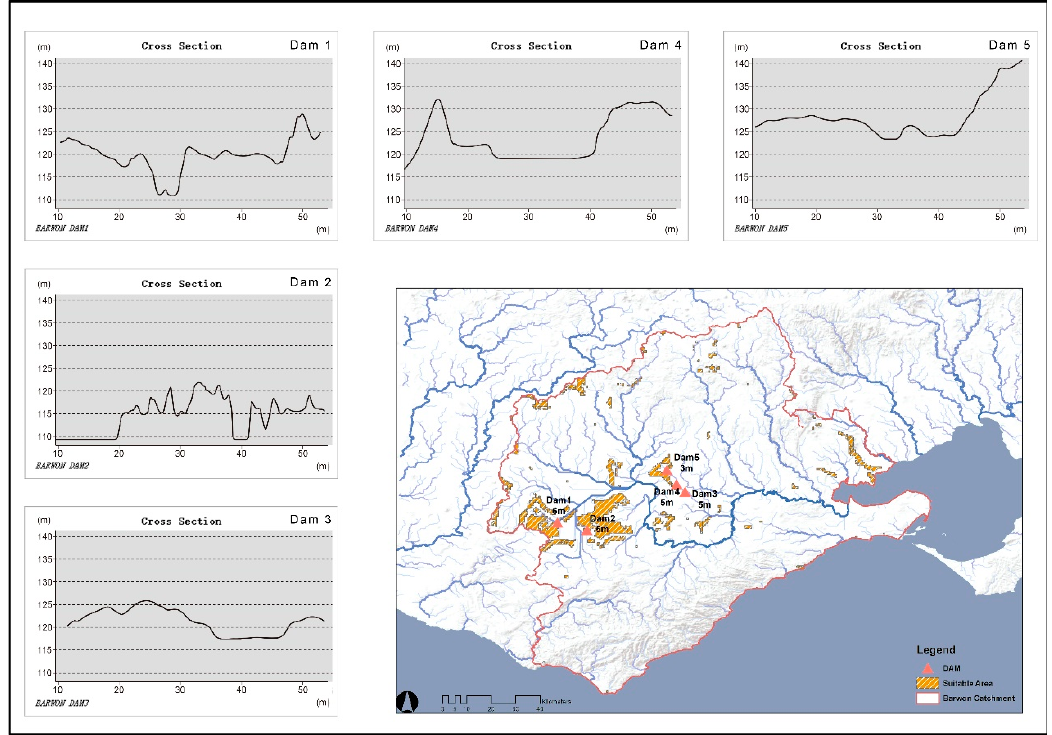
Figure 8. Assessment of dam locations in areas of high suitability.